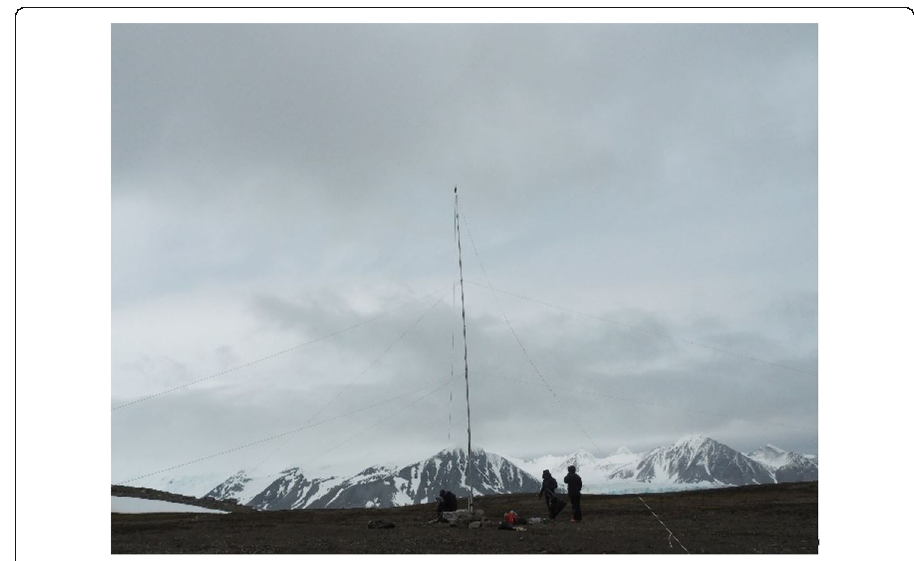
Fig. 22 Rocky Glacier remote node installation. Installation of second remote node in the Antarctica scenario. This node was situated 5 km away from the central